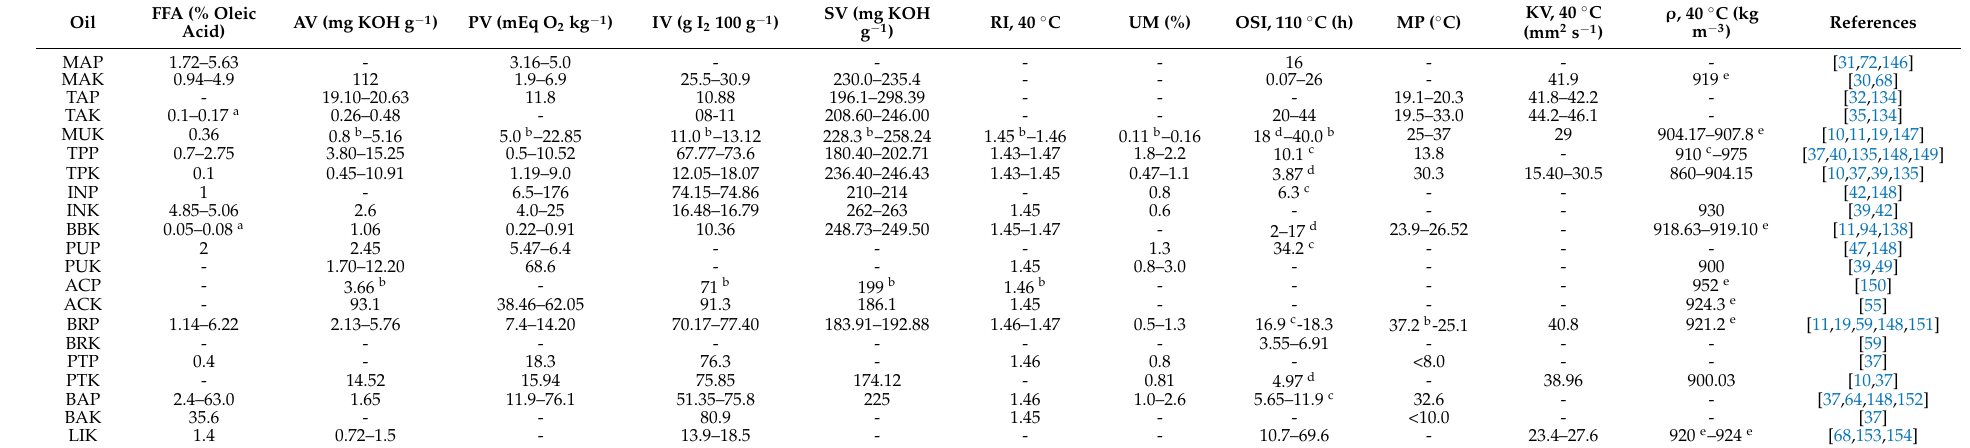
Table 2. Physicochemical properties of pulp and kernel oils from Arecaceae palm